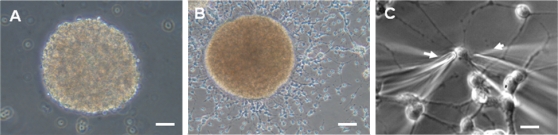
Neural progenitor cells.After forming a neurosphere, embryonic neural progenitor cells spread out into a monolayer. A. Neurosphere consisting of SVZ cells isolated at E15 that have aggregated in suspension after 2 days in culture. Scale bar: 100 µm. B. Neurosphere of SVZ cells derived at E15 that has attached to the floor of the culture flask after 4 days in culture. Note cells migrating away from the neurosphere. Scale bar: 100 µm. C. Cells at the periphery of neurospheres were chosen for electrophysiological recording. Most of the recorded cells extended processes. Arrows indicate the location of recording (left) and puffer (right) pipettes. Scale bar: 20 µm.